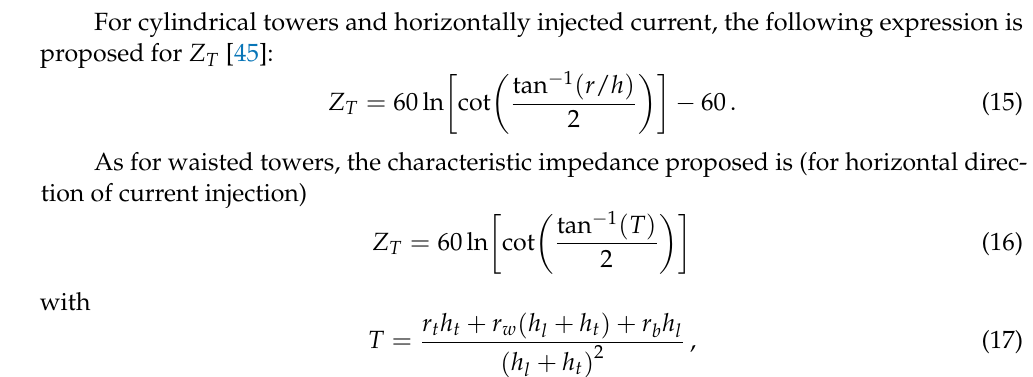
Figure 6. Biconical transmission line, used to approximate a conical tower with horizontal direction of current injection at its apex. ( a ) Generic biconical transmission line; ( b ) Biconical transmission line for tower application, with θ 2 = π